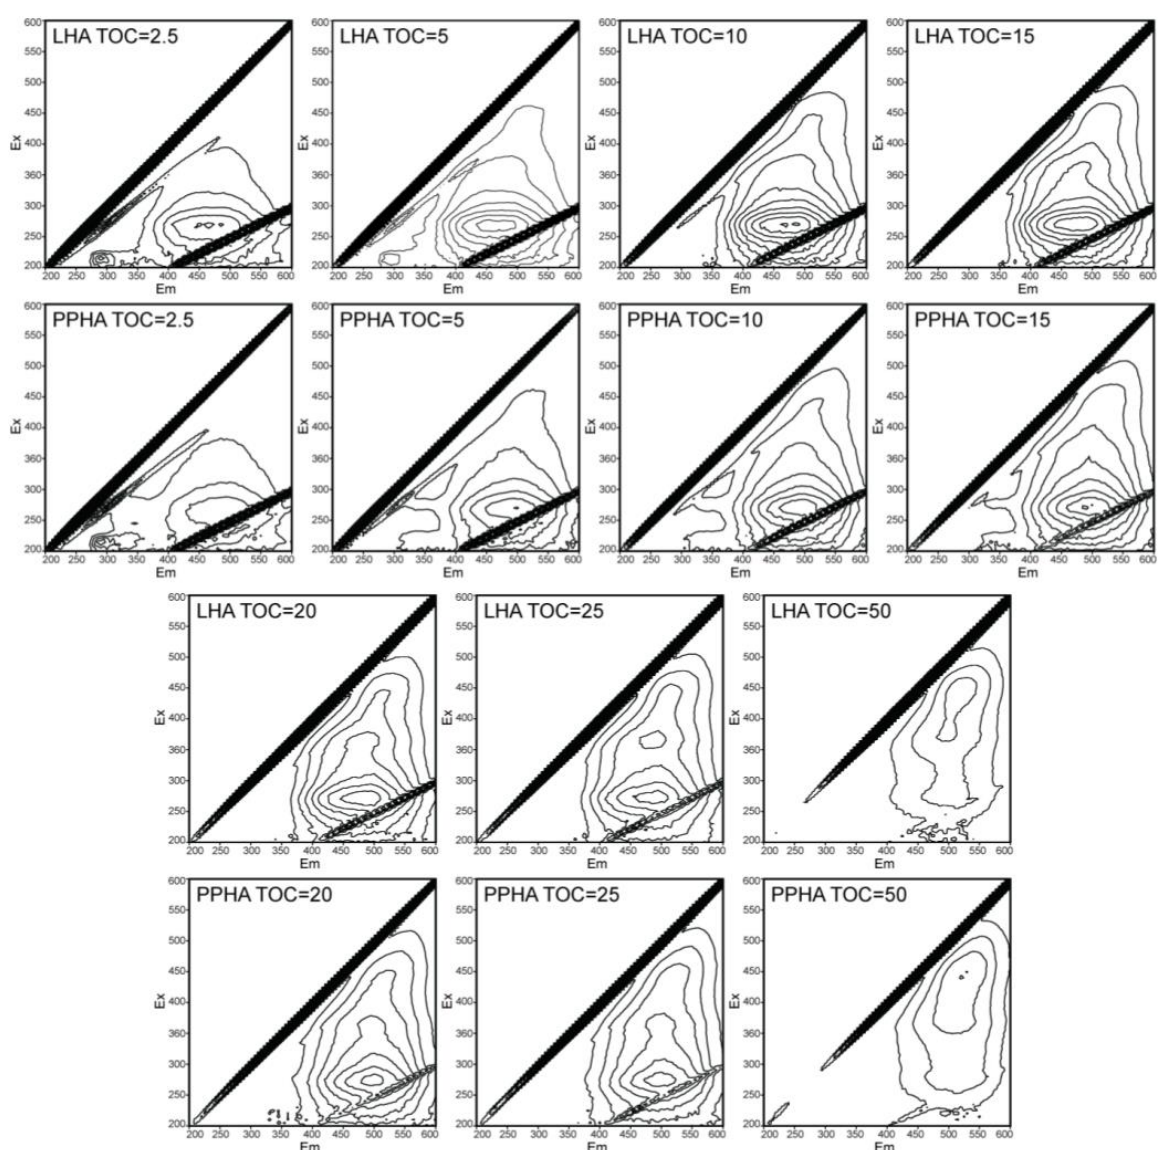
Figure 3. 3DEEM fluorescence spectra of PPHA and LHA samples with different TOC concentrations. In high TOC concentration range of 20–50 mg C/L, intensities of quinone-like flu- orophores were found gradually decreasing for both HA samples due to fluorescence- quenching occurrence, but a red-shifting in the peak positions appeared in high TOC concentration compared to in low TOC concentration range. For low TOC concentration range of HA increasing from 2.5 mg C/L to 15 mg C/L, intensities of quinone-like fluo- rophores were observed increasing along with the TOC concentration, and the red-shifting in peak positions of quinone-like fluorophores to a longer wavelength were also